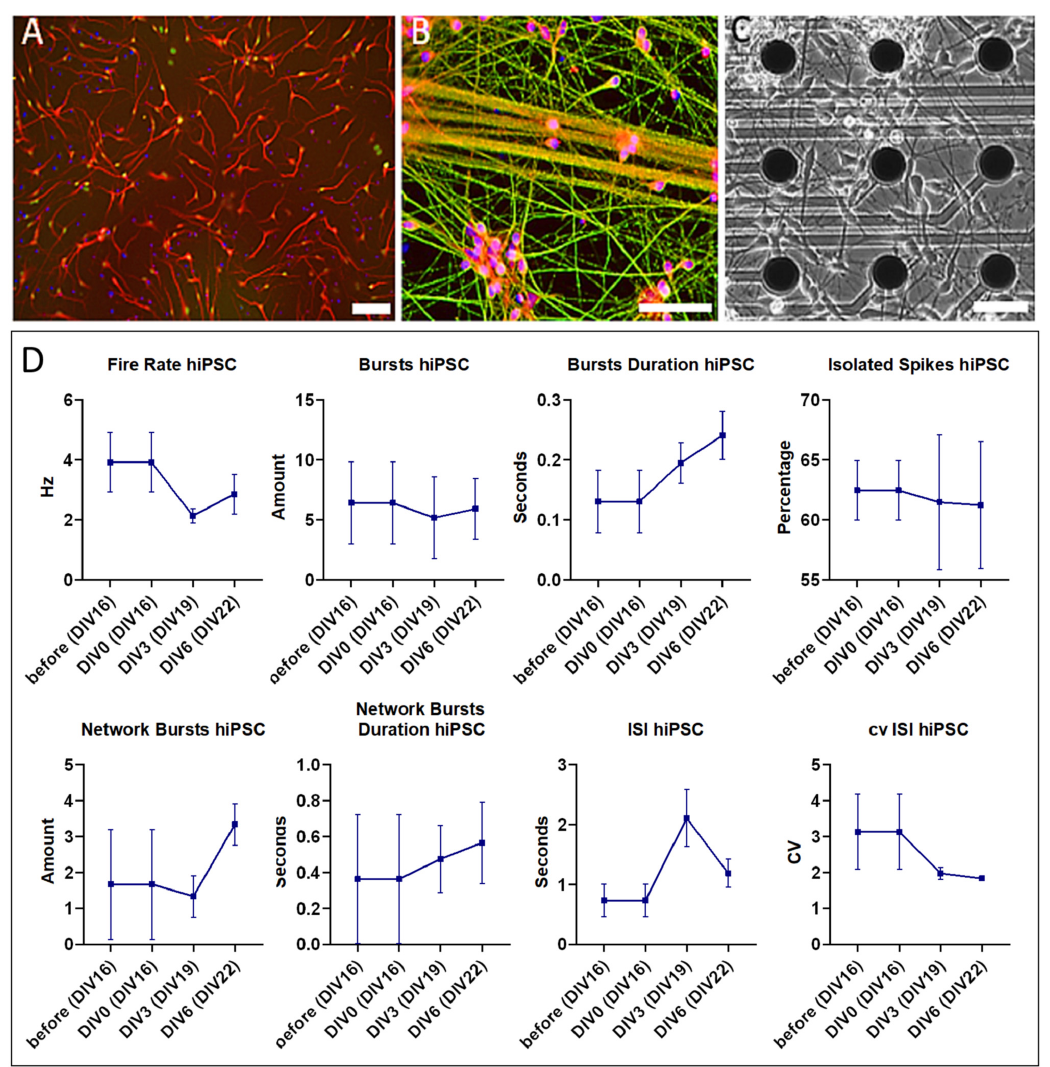
Figure 2. Image of hiPSC-derived cortical neurons cultured on (control) polystyrene ( A , B ) and the MEA ( C ) showing eight endpoints measured in parallel as controls ( D ); ( A ) after 7 days of differen- tiation, cells were (immuno)histochemically stained for neuronal marker MAP2 (red), indicating a successful induction of a neuronal lineage (Magnification 10×); ( B ) after 16 days (i.e., 7 days of dif- ferentiation and maintained for an additional 9 days in culture; DIV16), cells were (immuno) histo- chemically stained with markers for more mature neurons, including synaptophysin (red) and Beta tubulin III (green), and with nuclear marker DAPI (blue), indicating that the neurons matured and started to develop a network (Magnification 20×); ( C ) bright field image of hiPSC-derived cortical neurons that were cultured for 16 days on a MEA, representing the stage as used for assembly with the biopsy (Magnification 20×). All scale bars = 50 µm; ( D ) electrophysiological characterization of the control hiPSC-derived neuronal culture, measured at DIV16 (=before the assembly with the bi- opsy) and in parallel during the week of experiment (DIV0 to DIV6 neuronal cell + biopsy co-culture equivalent to DIV16 to DIV22 neuronal cell culture). Error bars represent mean with standard error of the mean (SEM) of three 2 min recordings per condition.